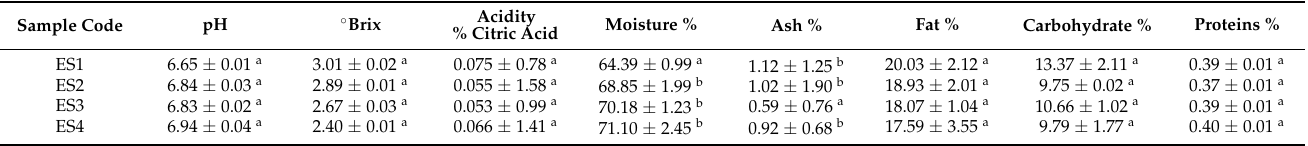
Table 3. Proximal composition of the dressing emulsion stabilized with hydrocolloids from butternut squash seeds (HBSSs) at pH